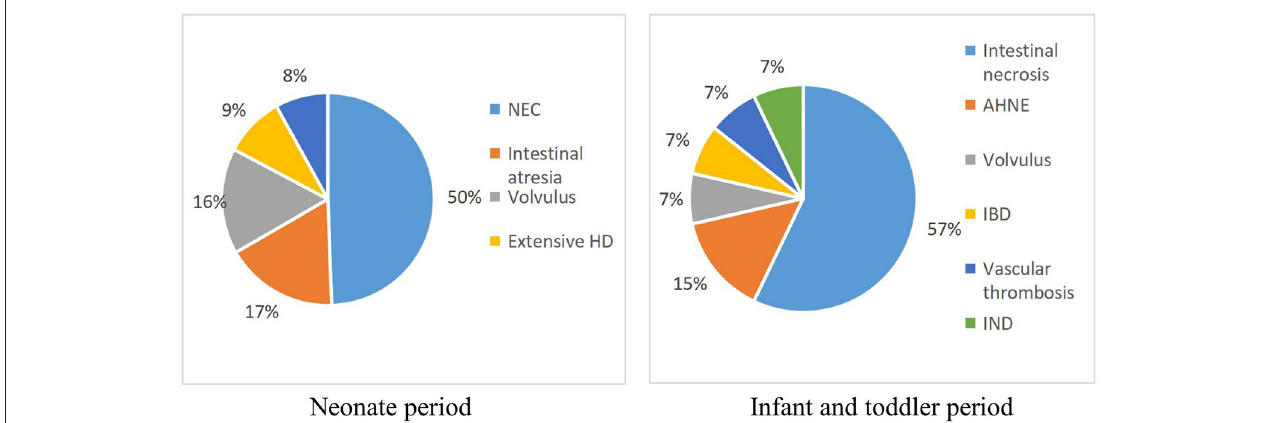
FIGURE 1 | Proportions of the different diagnosis in the study group. AHNE, acute hemorrhagic necrotic enteritis; HD, Hirschsprung disease; IBD, inflammatory bowel disease; IND, intestinal neuronal dysplasia;NEC, necrotizing enterocolitis.